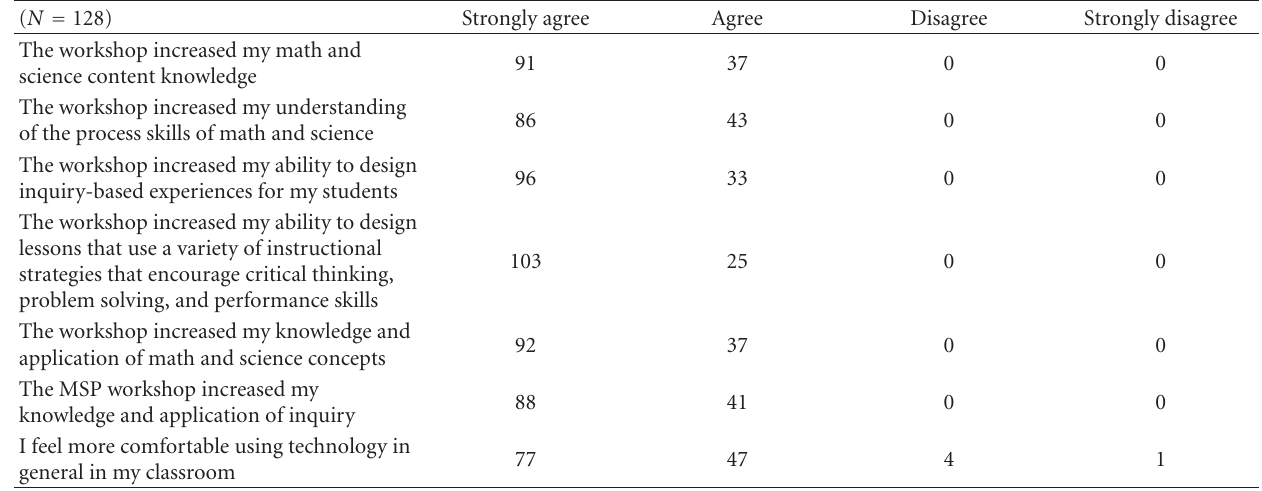
Table 3: Survey results related to science